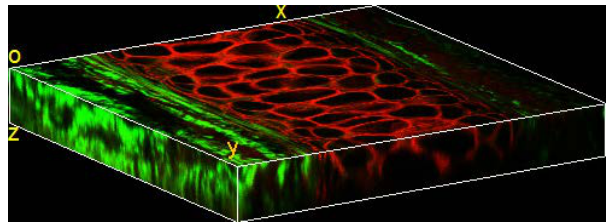
Fig. 3. 3D reconstruction of the sequential images shown in Fig. 2.